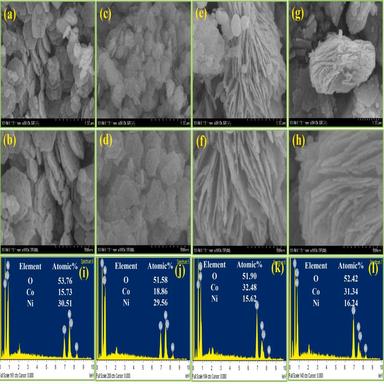
SEM images with different magnifications at various reaction durations after the temperature reached 140 ◦C: (a-b) 10 h, (c-d) 15 h, (e-f) 20 h, (g-h) 25 h along with their EDS spectra (i, j, k, and l) respectively.